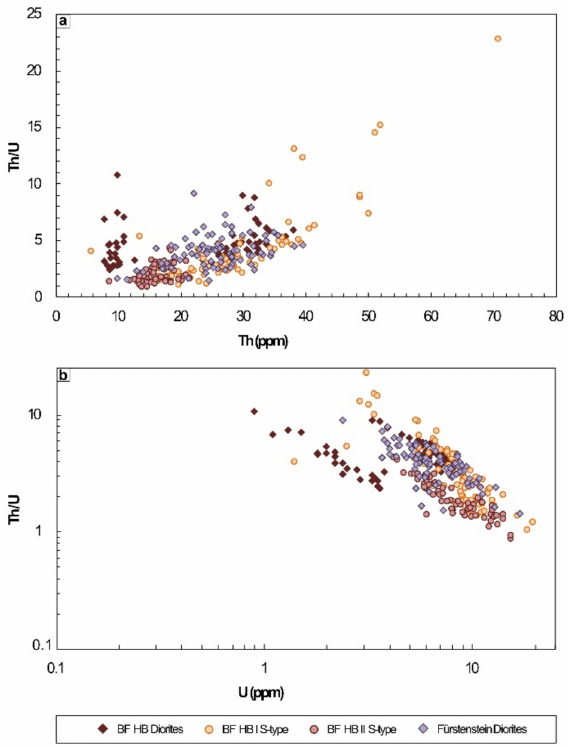
Figure 6. Th/U versus Th ( a ) and Th/U versus U ( b ) for the granites and diorites of the Bavarian